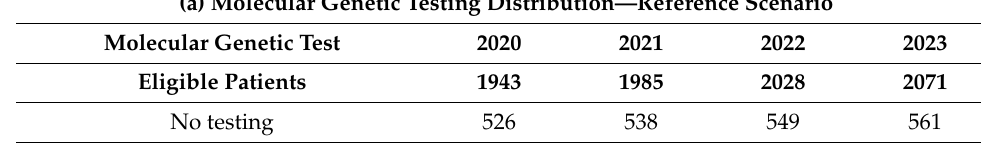
(b) Molecular Genetic Testing Distribution—New Scenario